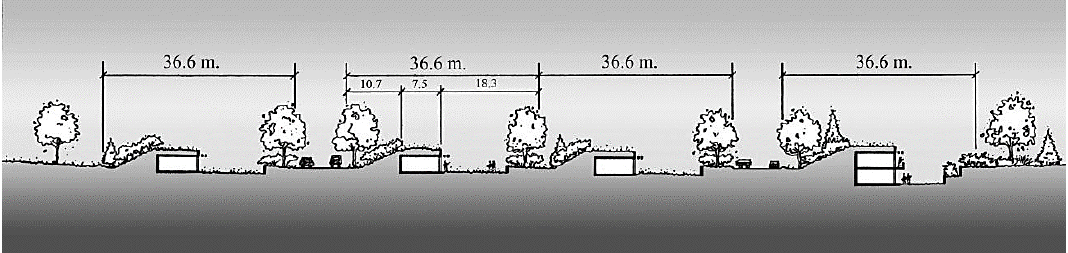
Figure 9. Cross-section for the required distance between units on flat site(Carmody and Sterling 1985). From the above, it is clear that the greater the slope degree the greater the density of the buildings at the site would be, but the accessibility is difficult to reach the high elevations and units located in the middle of the steep slopes. On the other hand, the smaller the slope the less the building density we will obtain and the easier to be built, but the construction cost will be high with low